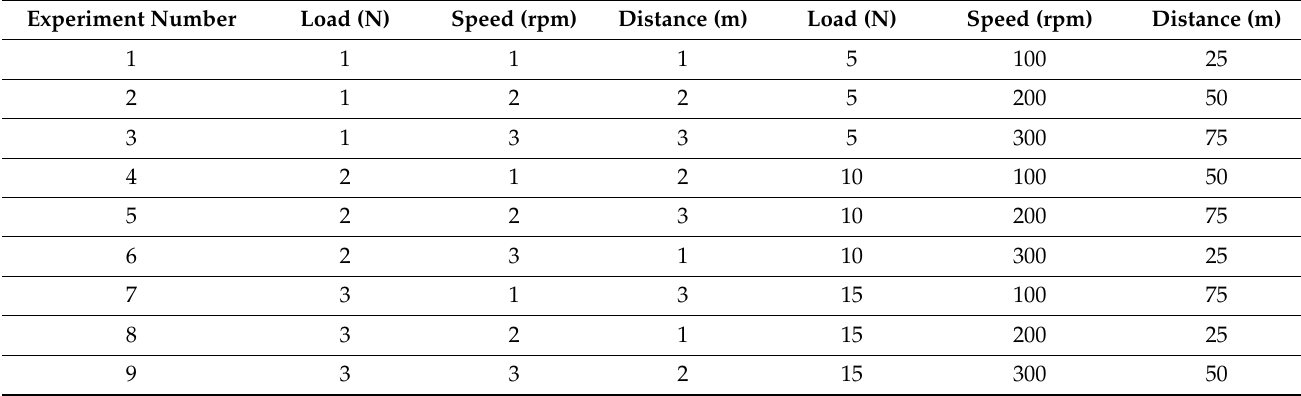
Table 2. L 9 OA with coded units and L 9 orthogonal array with un-coded